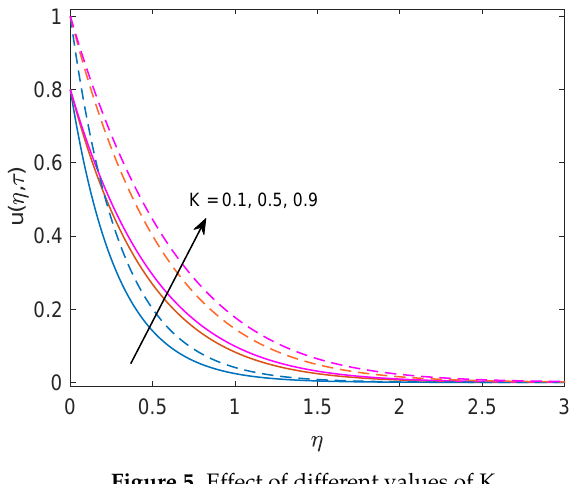
Figure 5. Effect of different values of K.